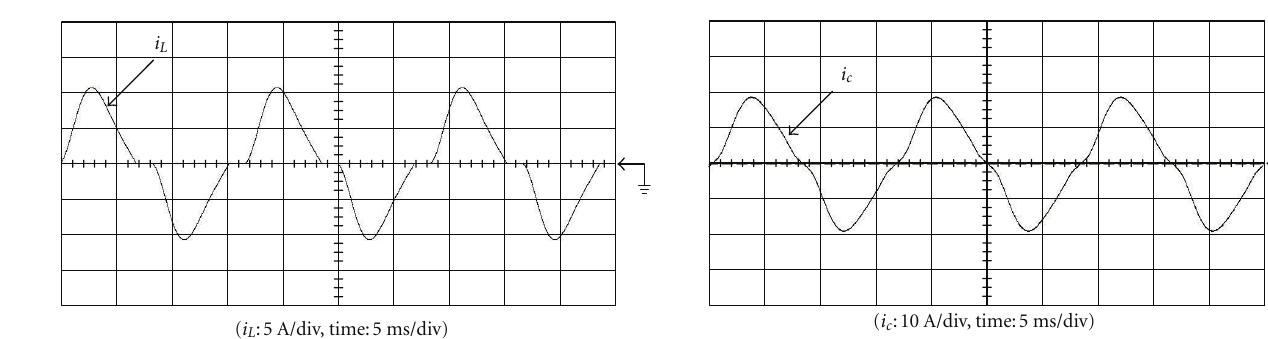
Figure 15: Load current while nonlinear loads are connected to utility.